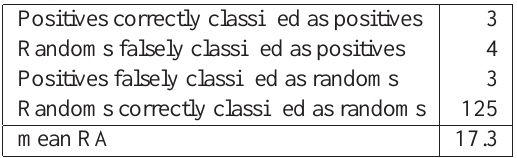
Figure 3: The model which predicts functional uORFs Table 6: A summary of classification and performance measurement of experiment generating a model which predicts functional uORFs (in Section